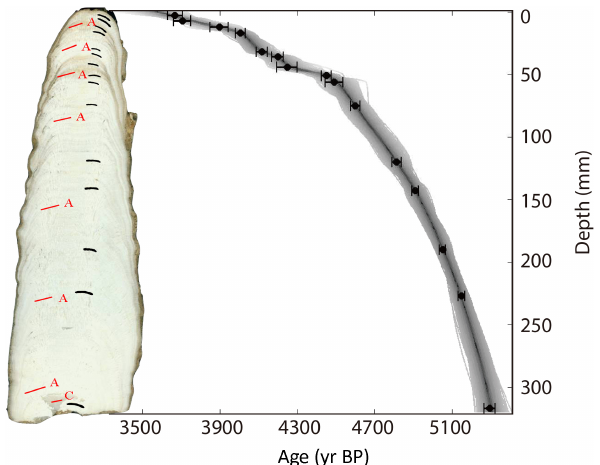
Figure 3. Polished section (left) and age model (right) of stalagmite SN17. Sampling positions for XRD analyses (red lines; A aragonite, C calcite) and 230 Th datings (black lines) are shown on the slab. SN17 age model and modeled age uncertainties using COPRA; er- ror bars on 230 Th dates indicate 2 σ analytical errors. The gray band depicts the 95% confidence